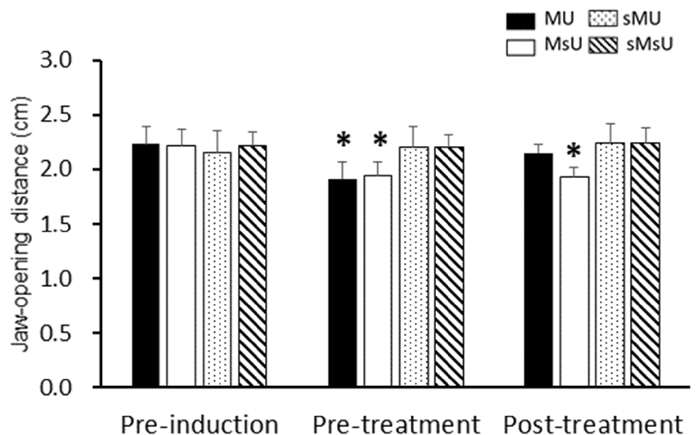
Figure 2. Maximum interincisal distance measured using Vernier caliper in four groups. Data of maximum jaw-opening distance are presented as mean ± SD at the pre-induction, pre-treatment, and post-treatment time points; *: p < 0.0083 indicates significant differences between either sMU or sMsU group tested by Mann–Whitney test.